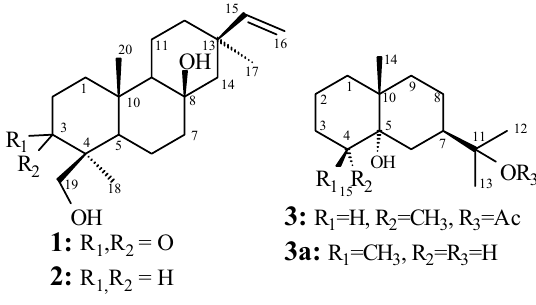
Fig. 1 – Compounds isolated from Salzmmania